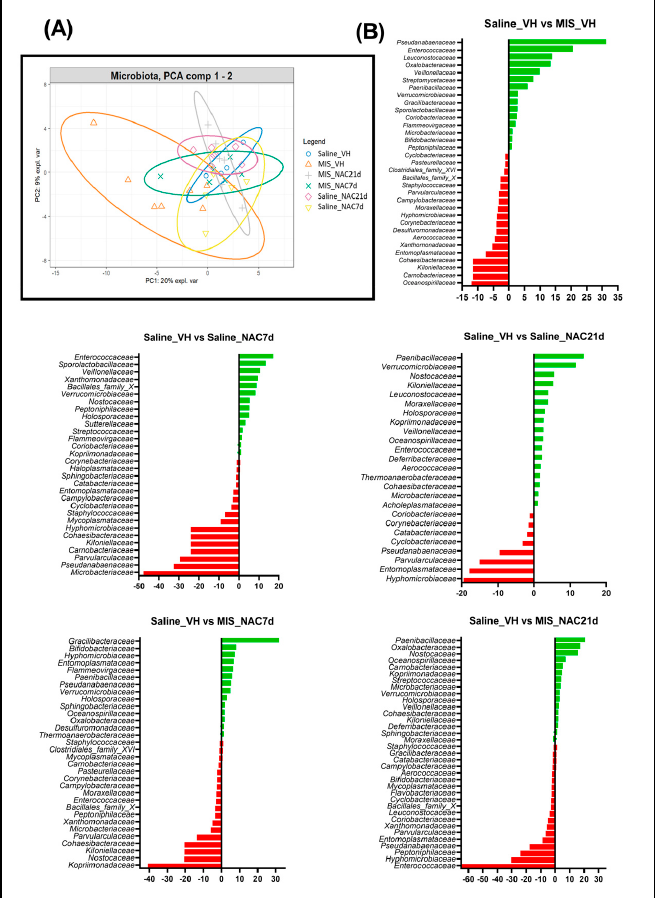
Figure 6. PCA and LDA analysis . ( A ). PCA cluster analysis of gut microbiota, which explains the 29% of the observed gut microbiota composition variance among groups. ( B ). LDA analysis among pairs of the different experimental groups, showing the families that better discriminate between the groups (Red: Saline-VH animals, Green: rest of